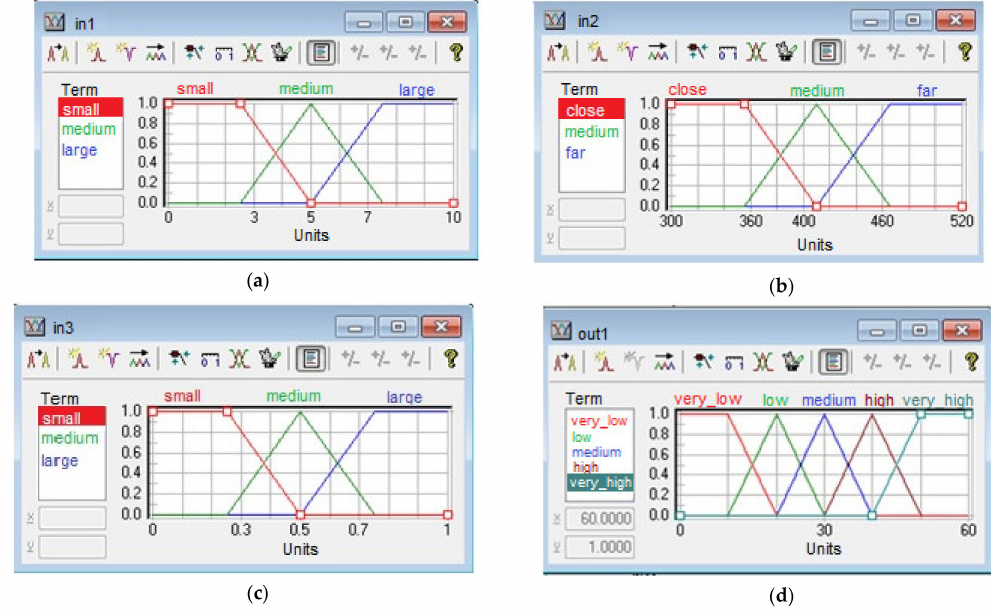
Figure 8. Distribution of values of input variables: ( a – c ) and output variable ( d